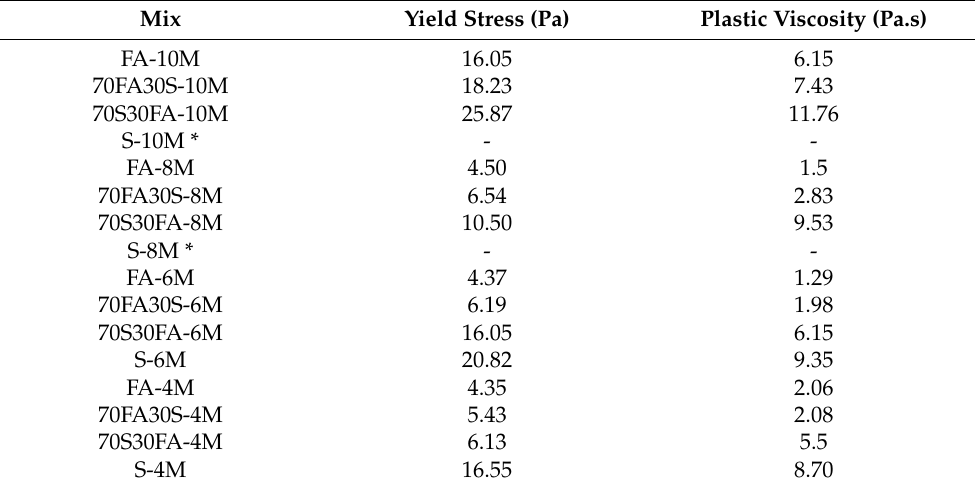
Table 2. Yield stress and plastic viscosity of alkali-activated